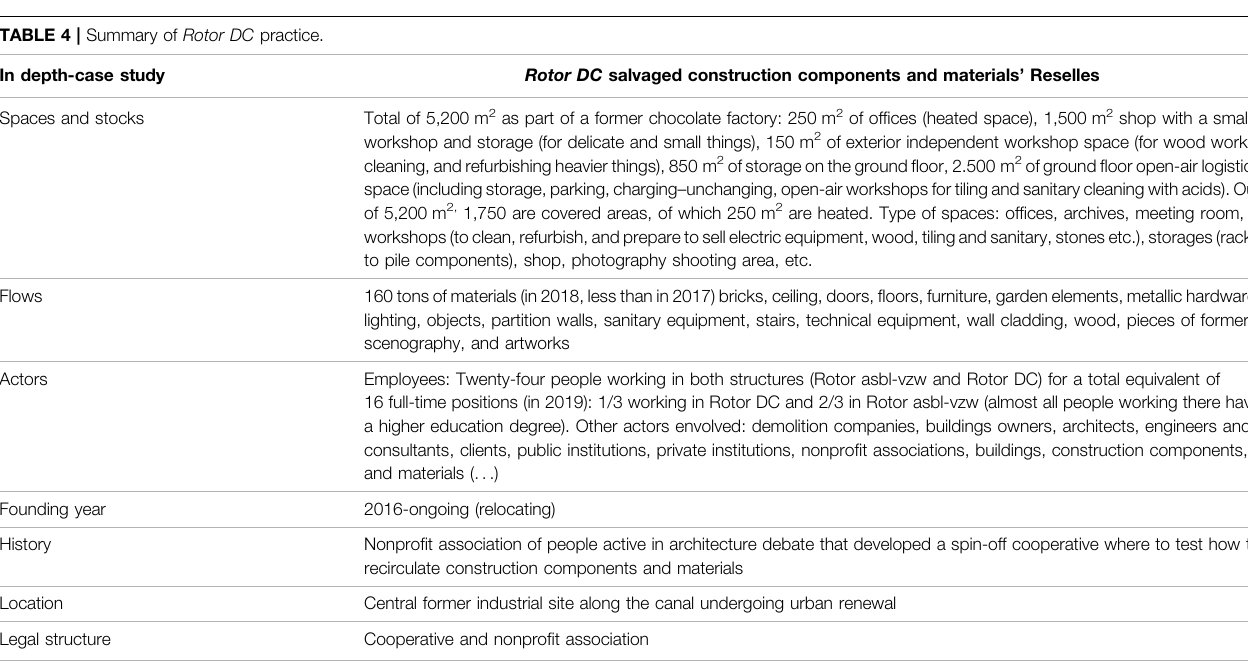
TABLE 4 | Summary of Rotor DC